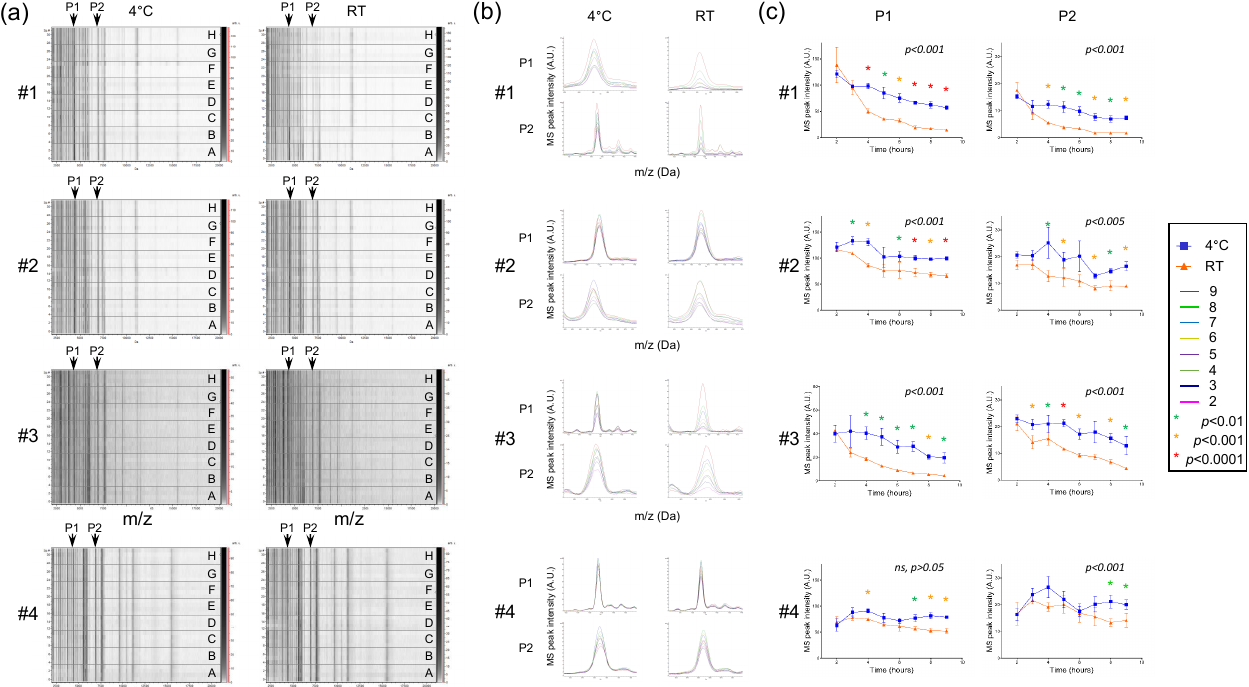
Figure 4. Assessment of storing mode and duration on saliva MS profiles. ( a ) Gel view of saliva MS spectra collected with Salivette and stored either at 4 ◦ C or room temperature (RT) during 2, 3, 4, 5, 6, 7, 8, or 9 h (A to H, respectively). The four replicates loaded on the MS plate for each individual per condition are presented. Two selected MS peaks, P1 ( m / z : 4372 Da) and P2 ( m / z : 6952 Da) are indicated by arrows. #1 to #4: healthcare workers. ( b ) Overlay profile view of selected MS peaks (P1 and P2) from kinetic collection according to storing mode. Line color code of storing time is indicated in the left part. ( c ) Graphical representation of the intensity of selected MS peaks (P1 and P2) according to duration and storing mode. One-way ANOVA, followed by Fisher’s LSD tests were done. p -values of one-way ANOVA were indicated on each graphic. Significant differences in peak intensities were indicated by colored asterisks (Fisher’s LSD). Standard deviations of intensities are represented by vertical lines. A.U.: arbitrary units; m / z : masse to charge